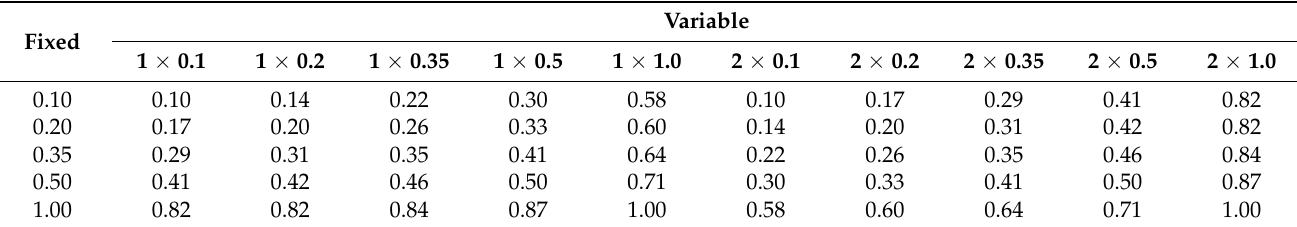
Table 15. Impact on the having various A , B and C values from the qualitative value set, with one (1 × ) or two (2 × ) values set at a different variable